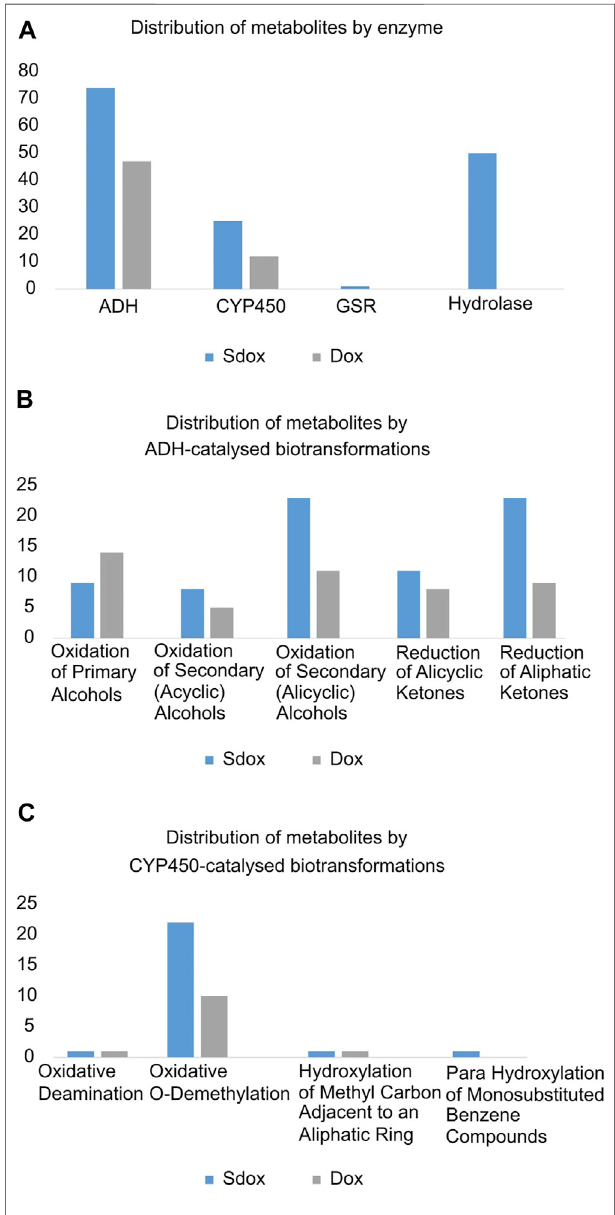
FIGURE 2 | Comparative analysis of Phase I biotransformations of Sdox and Dox. Distribution of metabolites by (A) enzyme, (B) ADH-catalysed, (C) CYP450-catalysed